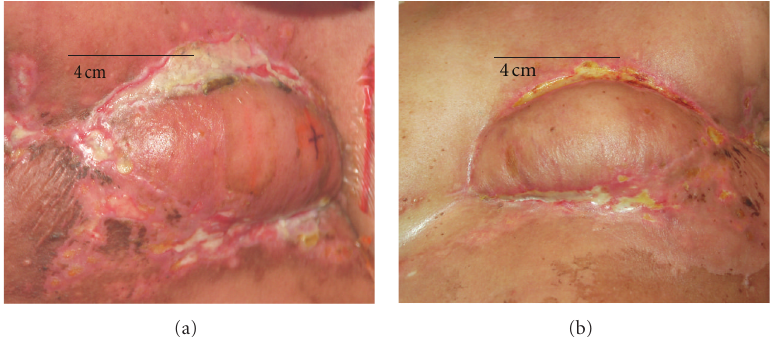
Figure 3: Breast cancer metastasis regression by salinomycin. Orthotopic subcutaneous metastases after mastectomy in a 40-year-old female patient (see Section 7.1 . Case 1) with metastatic invasive ductal breast carcinoma, triple negative (estrogen receptor: negative, progesterone receptor: negative, HER2: negative). (a) before, (b) after 12 intravenous administrations of 200 μ g · kg − 1 salinomycin every second day. Adapted from [104].